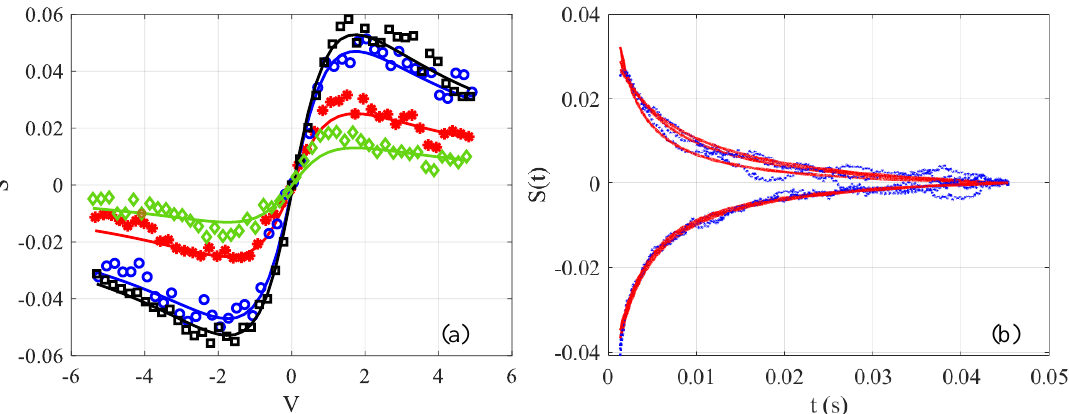
Figure 2. ( a ) Time-resolved Z-scan measurements. Transmittance Z-scan profiles for different final time values: 1.3 ms diamond (green); 3.3 ms stars (red); 13.3 ms circle (blue); and 23.3 ms square (black). Solid lines represent the fittings according to Equation (3a). ( b ) Transient experimental data and corresponding fitting by Equation (3b) for three values of z around the extremums of the signal S in water with ∅ = 0 (the measured values 𝜃 = 0.11 and 𝑡 𝑐0 = 0.7 ms) .